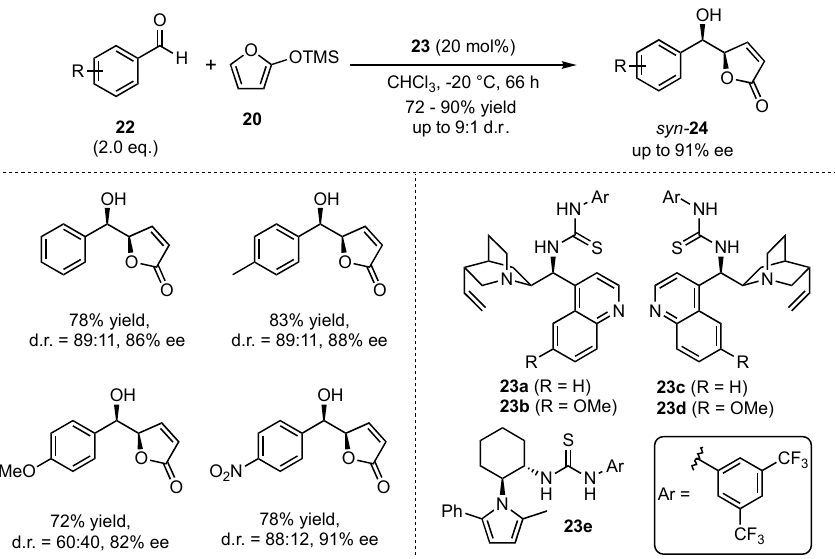
Scheme 7. Asymmetric VMAR between 2-(trimethylsilyloxy)furan and aromatic aldehydes organocatalyzed by bifunctional thioureas by Wang et al. [36].